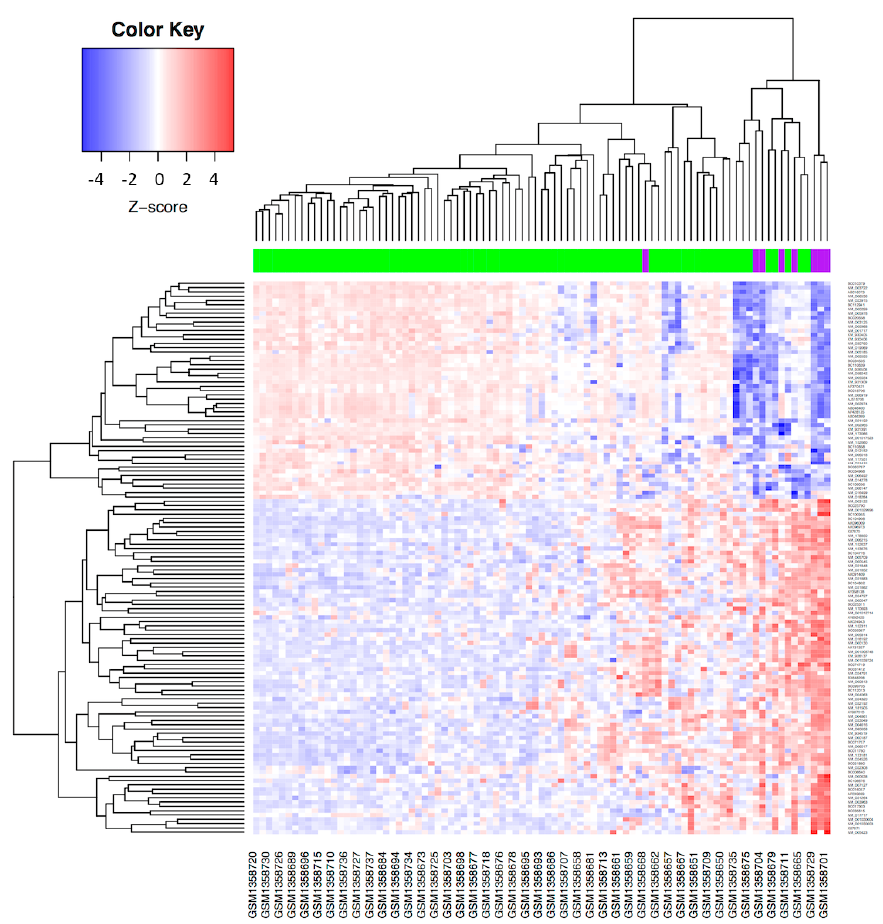
Figure 2. Molecular profile distinguishing ADC and SCC in CC patients from the Mexican-Mestizo cohort. Each column represents a patient with CC, and each row represents the expression of a gene. Gene expression changes are represented in blue (upregulated), red (downregulated) and white (no significant change or the absence of data). Patients with SCC are represented in green and ADCs in purple. In total, 130 transcripts separated Mexican-Mestizo CC patients into ADC vs. SCC subgroups (adj p -value < 0.05). Table 3. Top 15 DEGs in ADC versus SCC in the Mexican-Mestizo CC dataset.